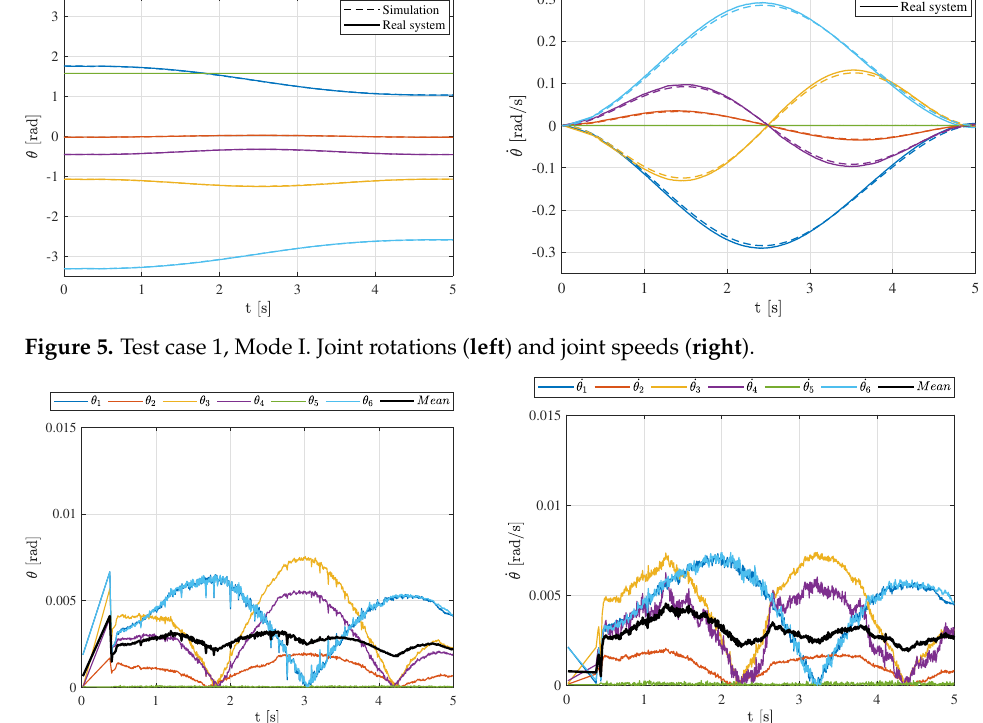
Figure 6. Test case 1, Mode I. Error between simulation and real system. Joint rotations ( left ) and joint speeds ( right